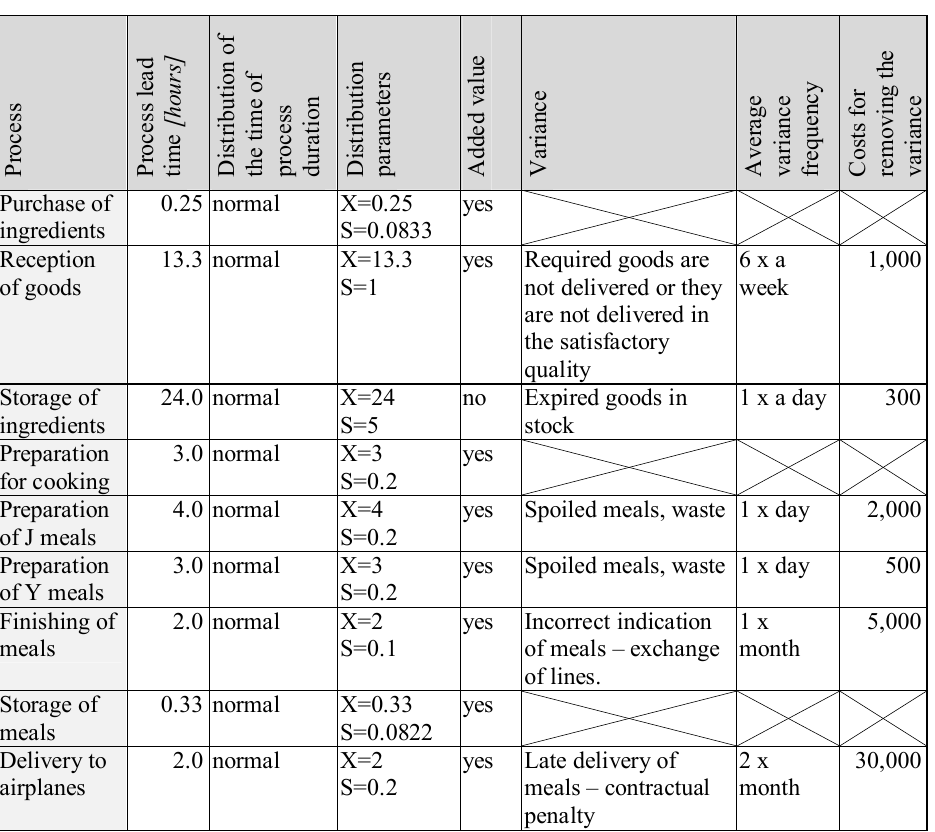
Table 3 – Process lead time and